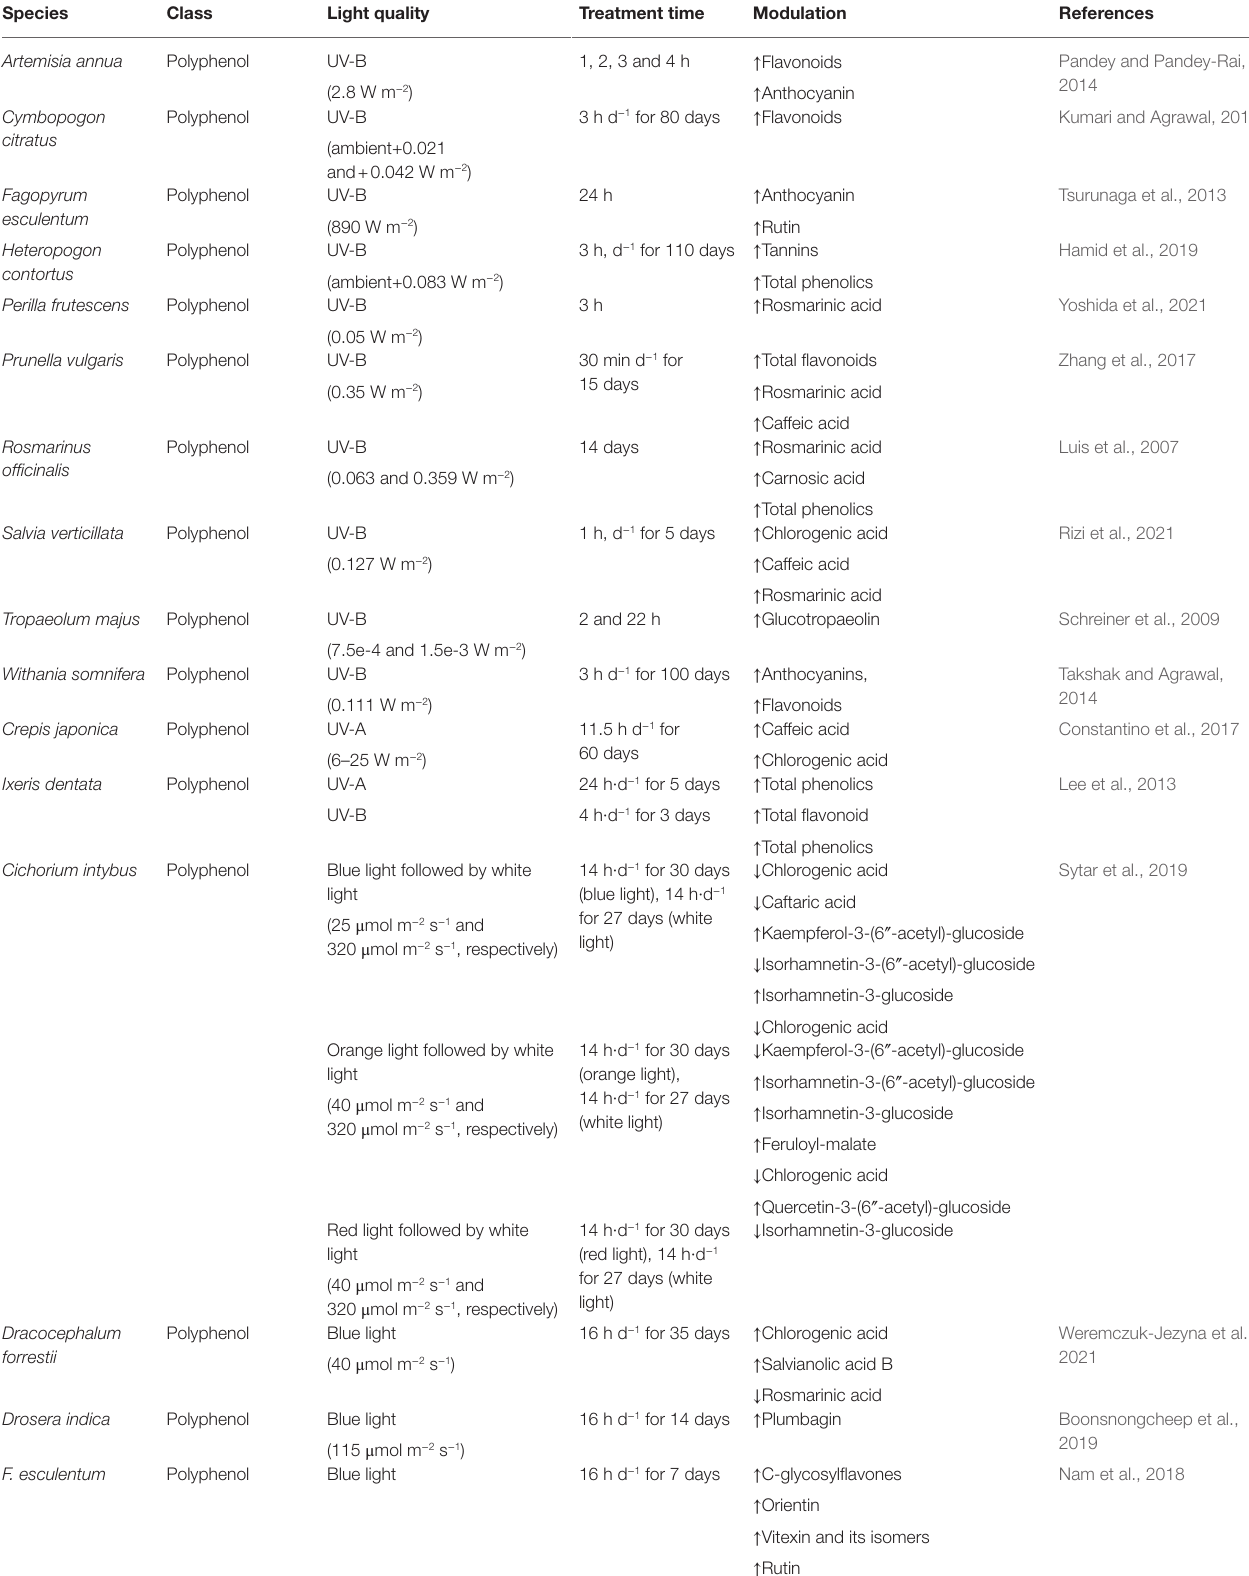
TABLE 1 | The effects of light quality on the accumulation of phytochemicals in some medicinal plants.